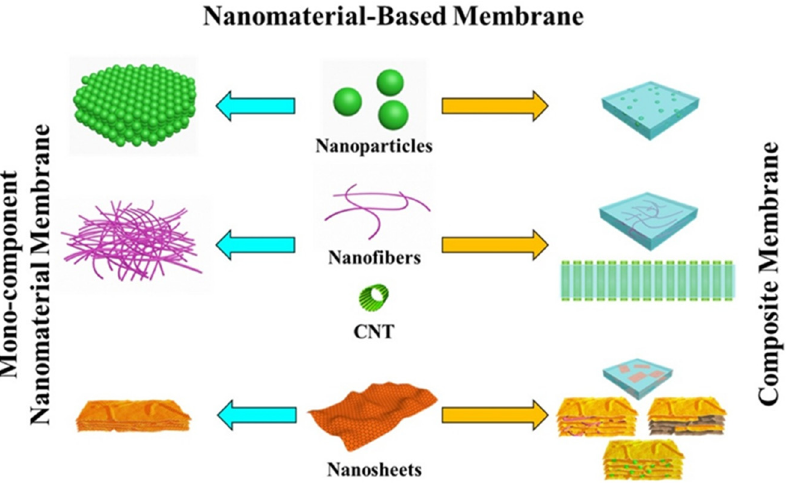
Figure 4. Nanomaterial-based membrane. Reprinted from [78] with permission from Elsevier, 2017.